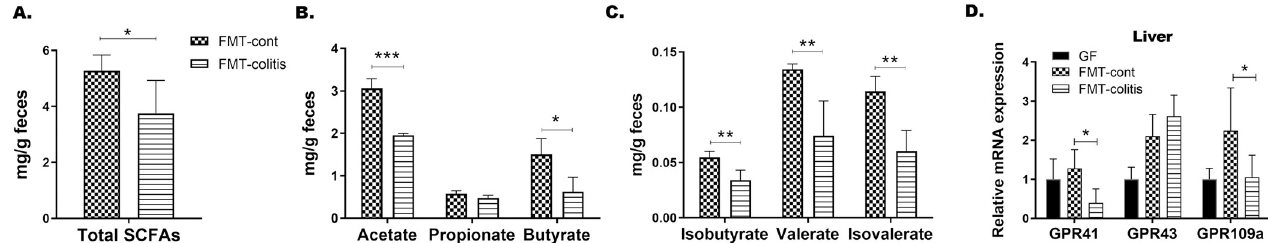
Fig 4. GF mice transplanted with fecal microbiota from colitis mice displayed decreased levels of SCFAs and their receptors. The fecal concentrations of (A) total SCFAs, (B) 3 major SCFAs, and (C) 3 minor SCFAs. (B) The mRNA expressions of SCFA receptors in the liver. Data are presented as the mean ± SD of each group (n = 5–7). Student’s two-tailed t-test was used for analysis difference between FMT-control and FMT-colitis ( � p < 0.05, �� p < 0.01, and ��� p <